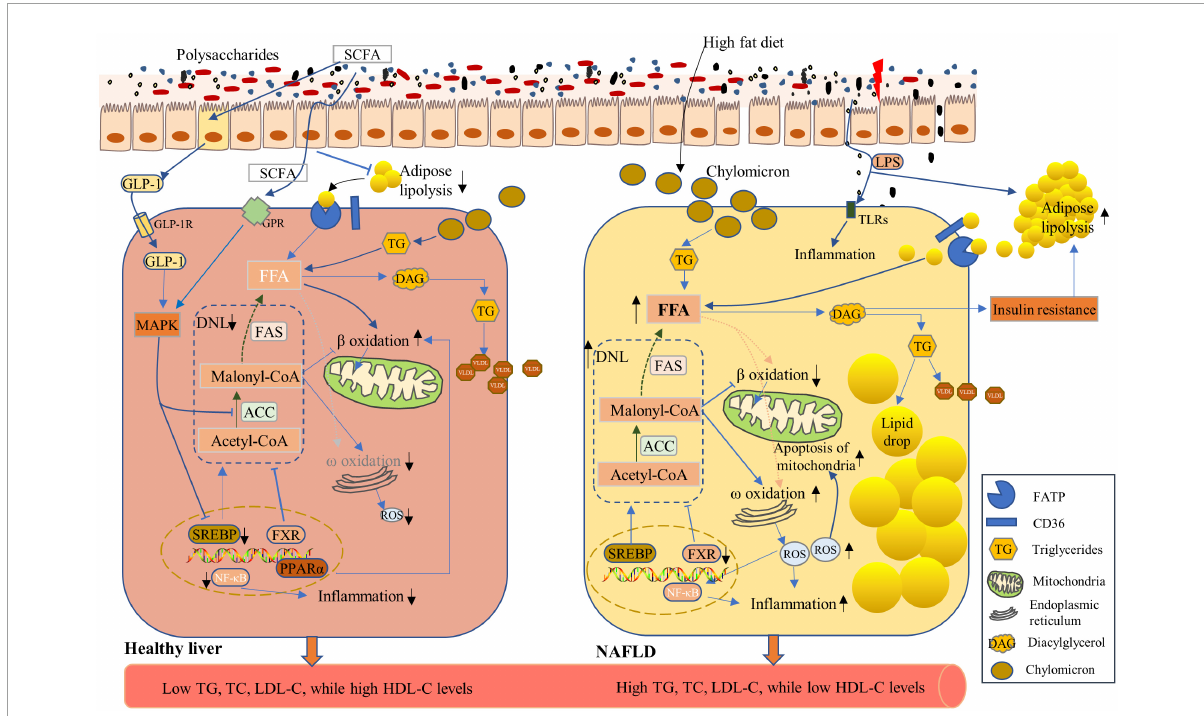
FIGURE5 Effects of polysaccharides on the non-alcoholic fatty liver disease (NAFLD). NAFLD is characterized by increased lipid accumulation within hepatocytes, mainly through the uptake of chylomicron processed from dietary fat, circulating free fatty acids (FFA) from lipolysis of adipose tissues, and elevated de novo lipogenesis (DNL) (119, 123) (Right Panel) , leading to high levels of triglycerides (TG), total cholesterol (TC), and low-density lipoprotein-cholesterol (LDL-C), as well as low levels of high-density lipoprotein-cholesterol (HDL-C) in the serum. High-fat diet induces high levels of chylomicron storage in the hepatocytes, which contributed to high FFA levels in hepatocytes. An intermediate metabolite in triglyceride synthesis, diacylglycerol (DAG), induces insulin resistance, which further enhances the lipolysis of adipose tissues and the subsequent high FFA concentrations. FA synthesis is catalyzed by acetyl-CoA carboxylase (ACC) and fatty acid synthase (FAS), and their expression can be induced by sterol-response-binding-protein-1c (SREBP-1c) and be inhibited by farnesoid X receptor (FXR). Under NAFLD conditions, SREBP-1c expression was enhanced with enhanced DNL (Right Panel) . Polysaccharide application enhanced the expression of FXR and reduced DNL. Lipid accumulation within hepatocyte was limited, and FA oxidation was enhanced via improved β -oxidation and GLP-1 function to ensure healthy hepatic lipid metabolism (Left Panel)